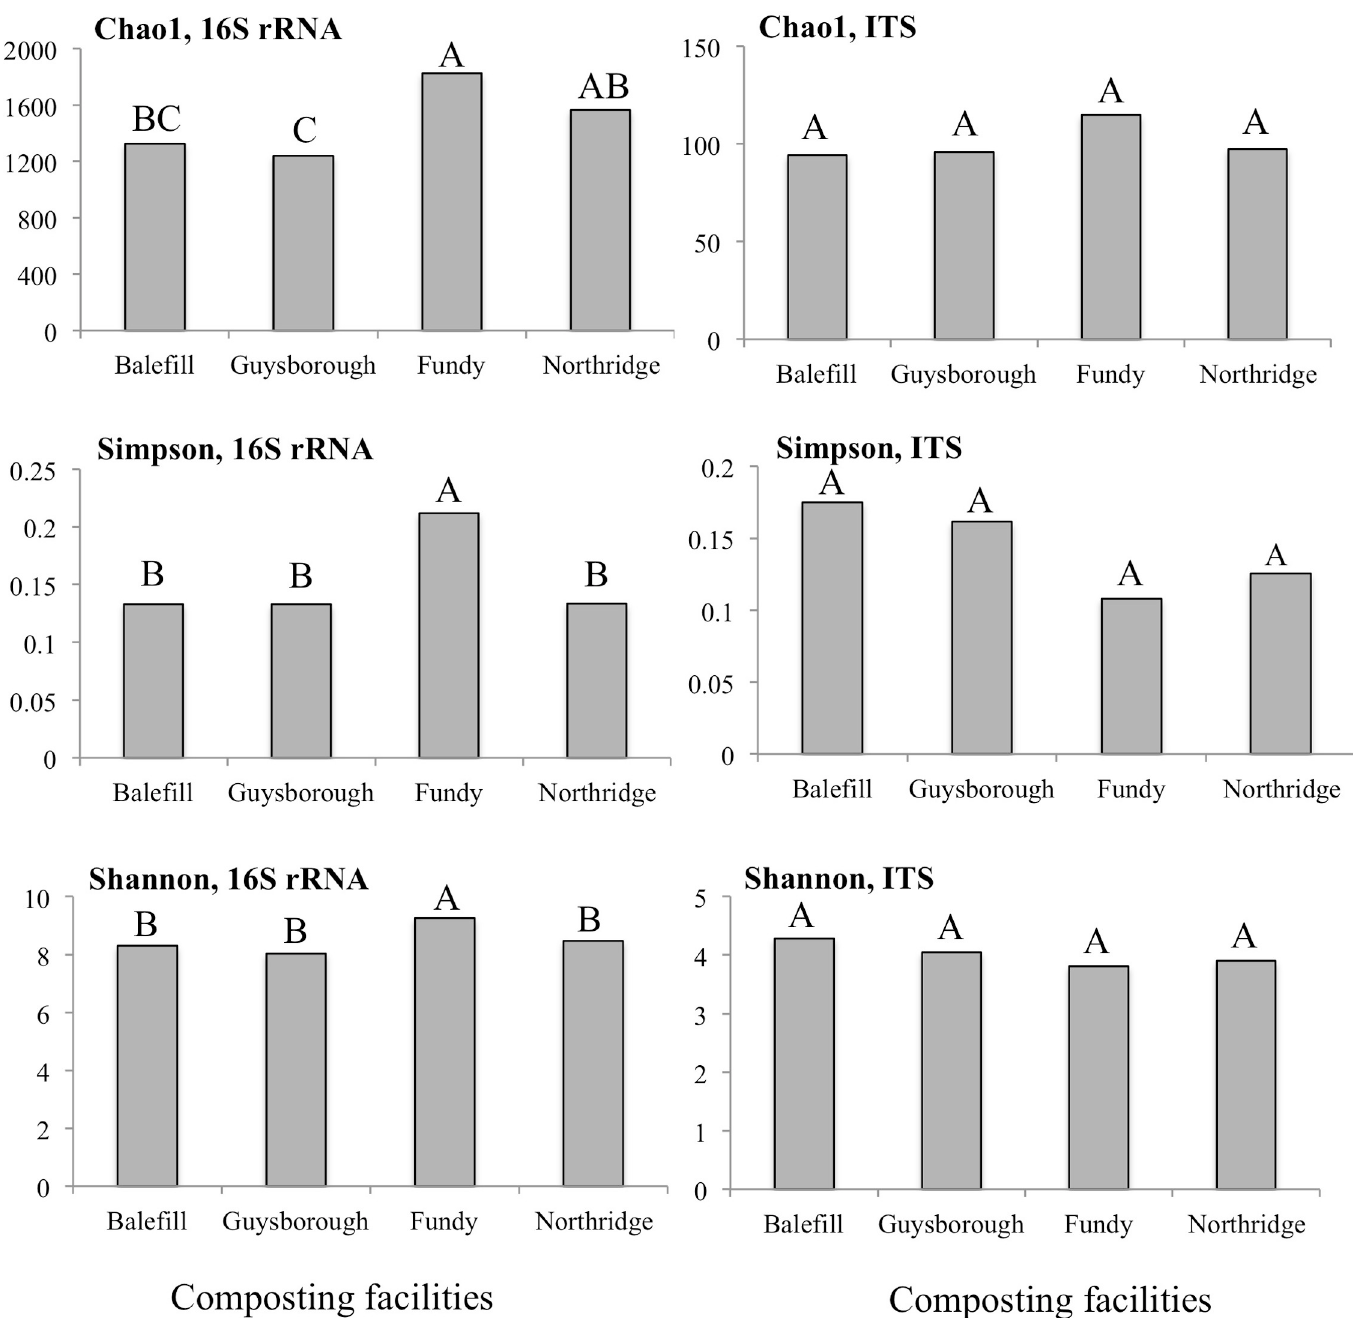
Fig 3. Estimated total species Chao1 richness, Simpson evenness and Shannon diversity. For each variable, data followed by different letters are significantly different according to Tukey’s pairwise test (P < 0.05). indicate that Sample Type influence bacterial or fungal community structures (S1 Table). Simi- larly, no statistical significance of sample groupings was detected when communities from each facility were considered separately. Likewise, no differences in bacterial or fungal alpha-